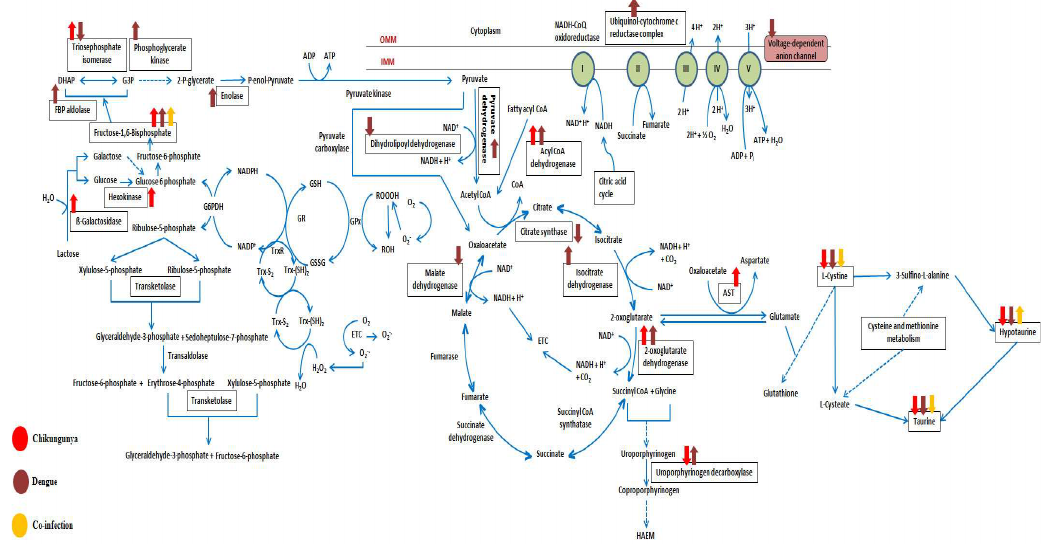
Figure 6. The figure represents important biomolecule predicted from transcriptome, proteome and metabolomics study related to oxidative stress upon CHIKV/DENV mono- and coinfection. The biomolecules related to oxidative stress identified in the present study are written inside the box. Red colour represents proteins from CHIKV infected samples, Brown represents proteins from DENV infected samples and yellow colour represents results obtained from co-infection data.